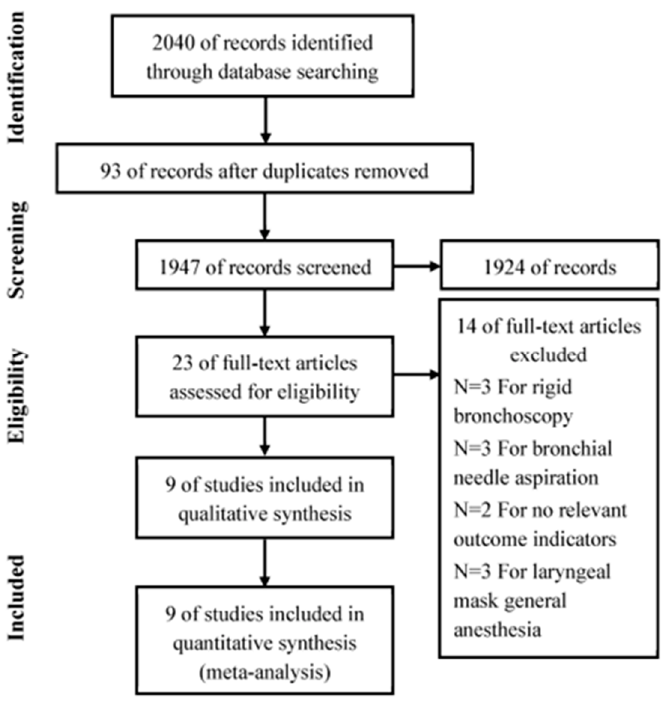
Figure 1. Flow chart of article selection for the meta-analysis.